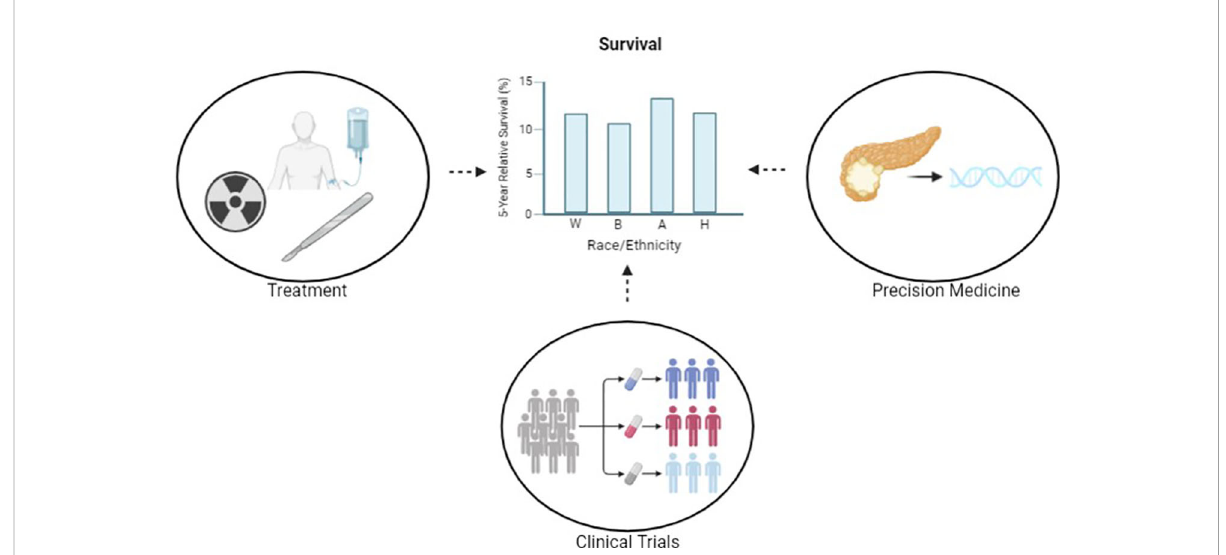
FIGURE 1 Through the pursuit of equitable care in precision medicine, clinical trials and treatment, we aim to reduce disparities in outcomes. Reported survival statistics are based on SEER 5-year relative survival rates 2012-2018. Created with